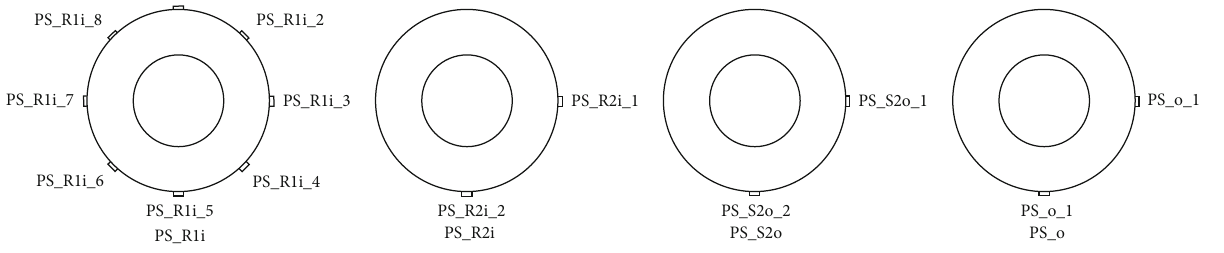
Figure 6: Measurement point sketch of the high-speed axial compressor.